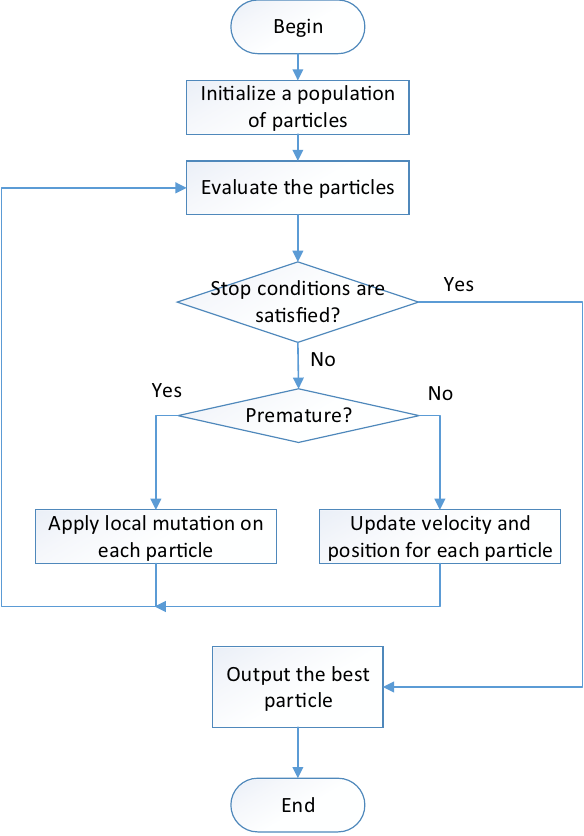
Fig. 2 The flowchart of